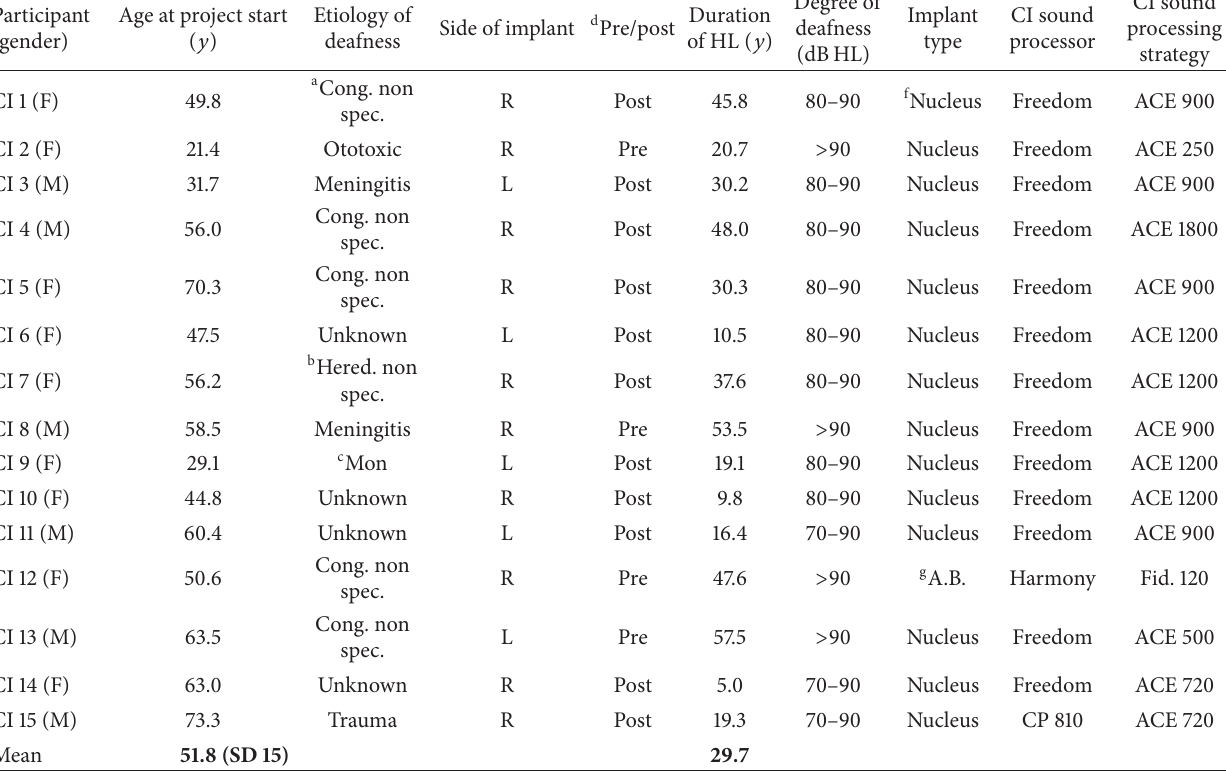
Table 1: Clinical and demographic data for the 15 participants included in the